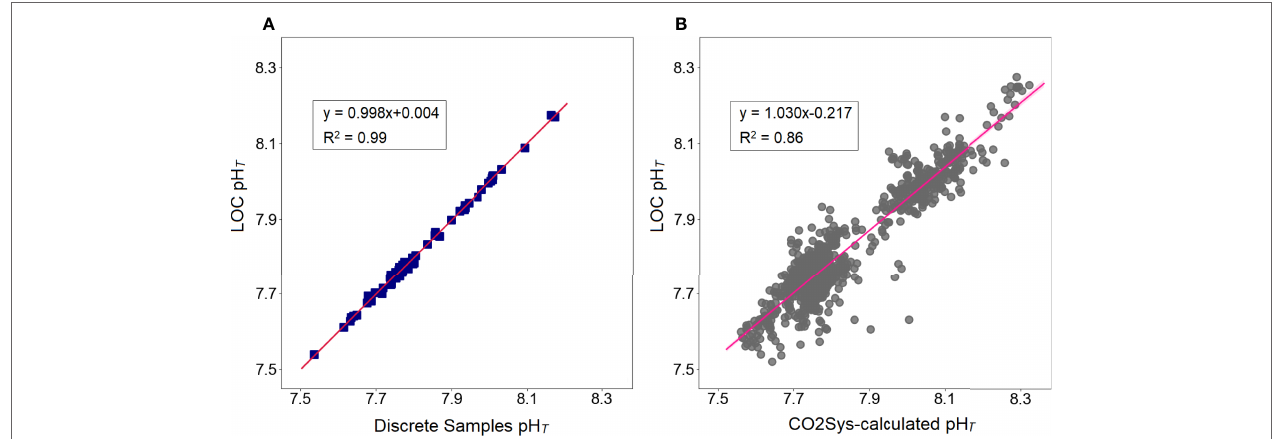
FIGURE 2 | Linear regression fits between all summer and autumn pH T values obtained from (A) discrete water samples vs LOC sensor (data: blue squares, linear fit; solid red line, n=65), and (B) CO2Sys-calculation vs LOC sensor (data: grey circles, linear fit; solid pink line,